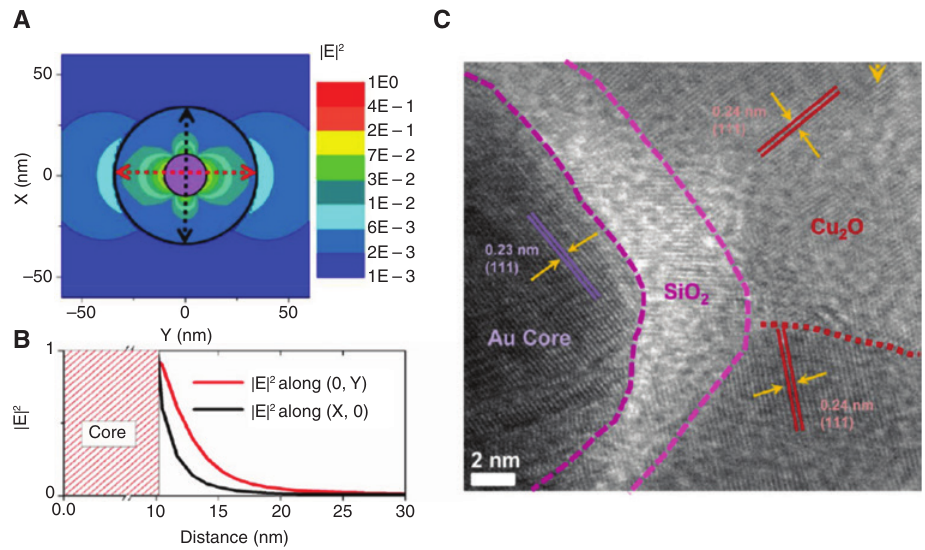
O. 2 @Cu O interface regions. Adapted with permission from Ref. [104]. Copyright 2 2